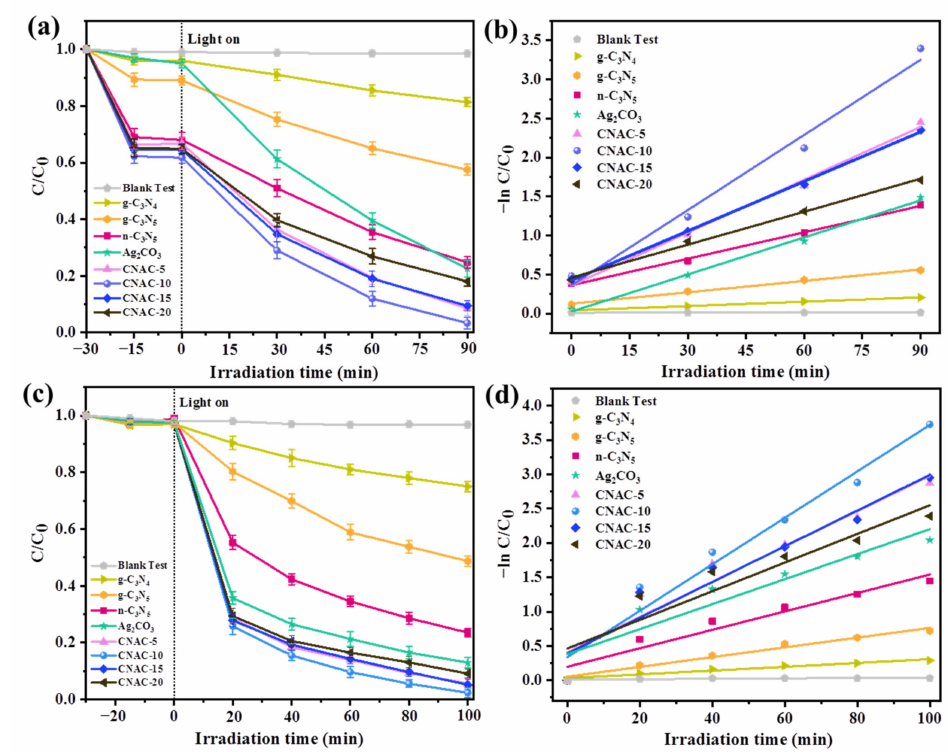
Figure 8. ( a , c ) The photodegradation of MB and TC-HCl in the presence of as-prepared catalysts under visible light irradiations and ( b , d ) corresponding reaction kinetic constants of different samples under visible